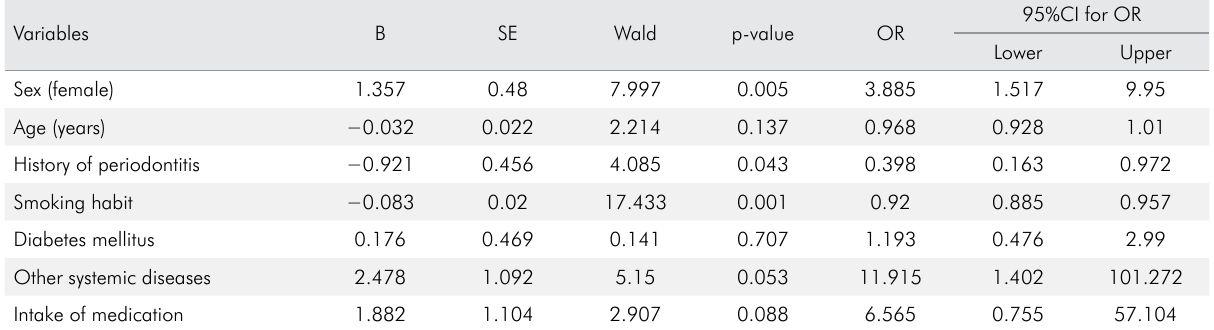
Table 6. Univariate binary logistic regression for short implant success at patient level.